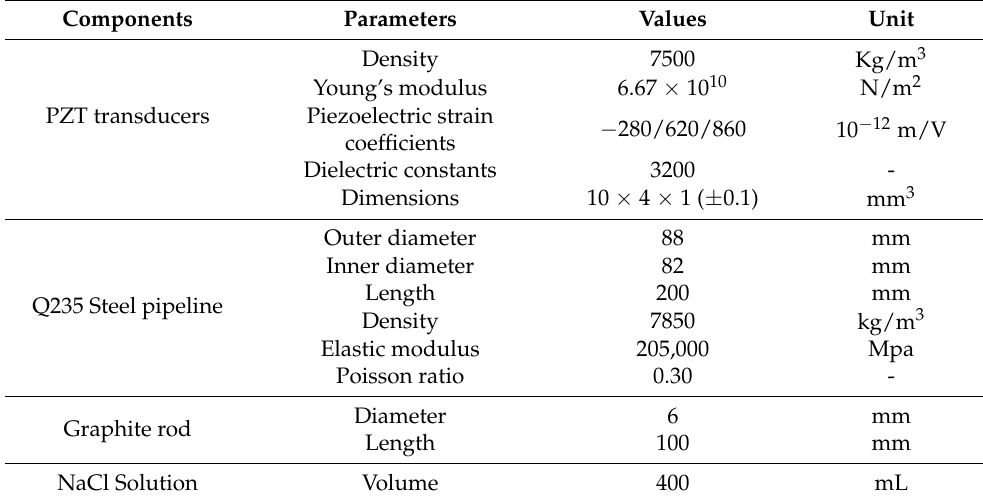
Figure 4. Electrochemical corrosion device. Table 2. Sample pipeline and experimental device-related parameters.